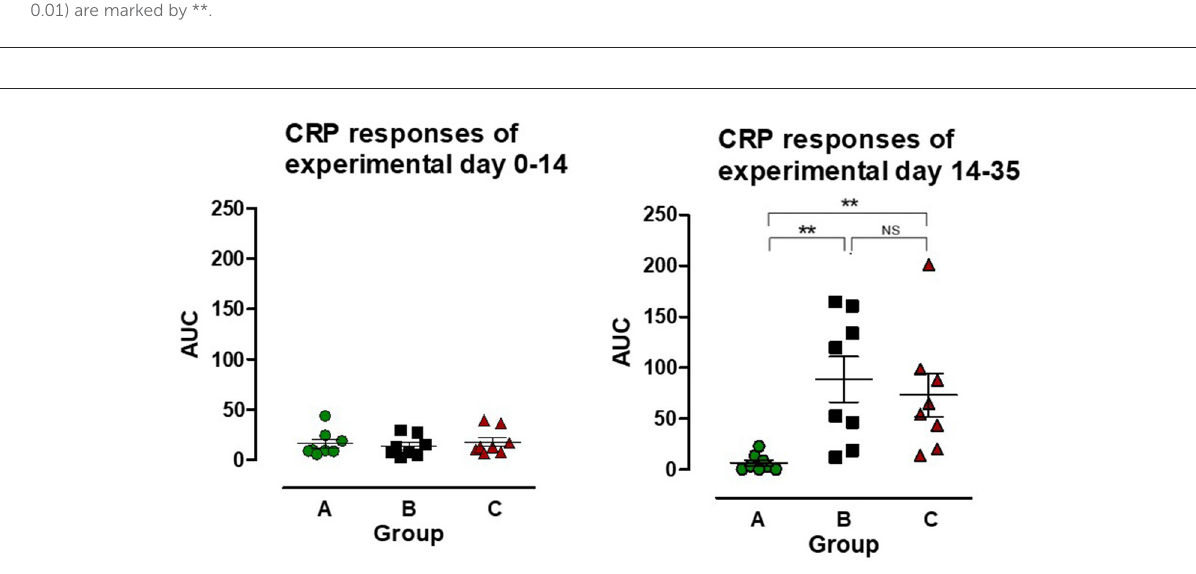
FIGURE4 The area under the curve (AUC) for C-reactive protein (CRP) was calculated for individual pigs in the three groups: A ( ), B ( ), C ( ) for the period after PCV2 inoculation (experimental day 0–14) and after Lawsonia intracellularis /PCV2 challenge (experimental day 14–35), respectively. Individual values as well as mean ± SEM for the group are shown. NS = non-significant. Significant results ( p < 0.01) are marked by